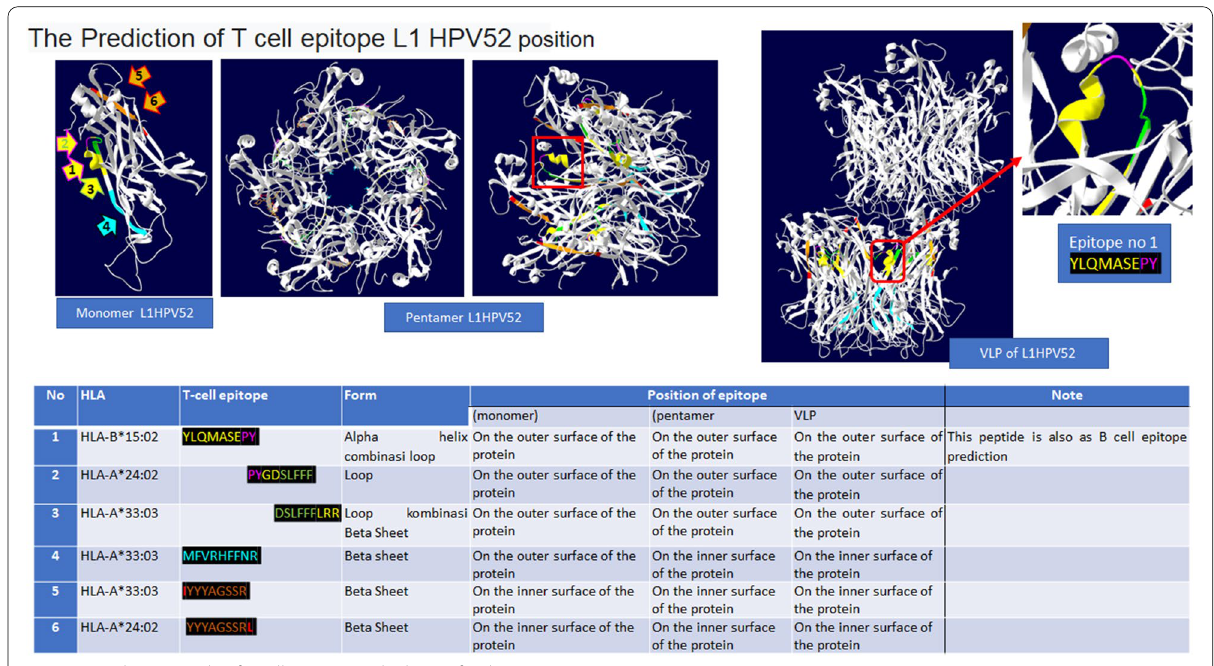
Fig. 13 Prediction study of T cell epitope with class I of Indonesian HLA